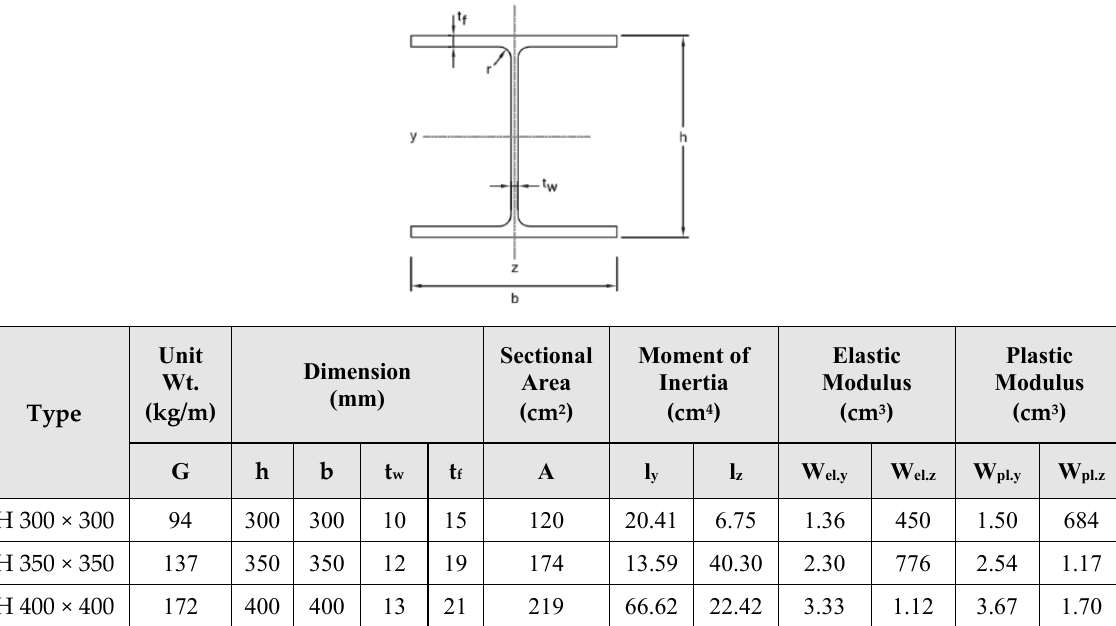
Figure 9. Types of kingposts in Thailand.